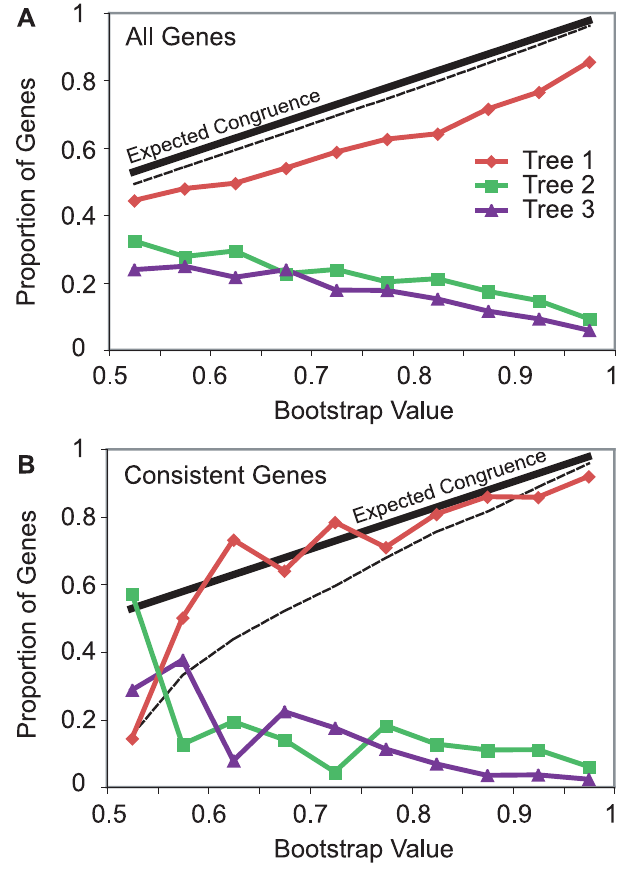
Figure 7. Significance of Incongruence An excess of incongruence above what is expected by chance was observed for the set of all genes (A) as well as the set of genes that consistently supported the same tree across models and species combinations (B). Genes were binned by bootstrap value, and the proportion of genes supporting tree 1 (red line), tree 2 (green line), and tree 3 (purple line) were plotted. The expected congruence based on the bootstrap value in each bin (black solid line) and the 95% confidence interval based on a X 2 distribution (black dash line) demonstrate the excess incongruence. DOI: